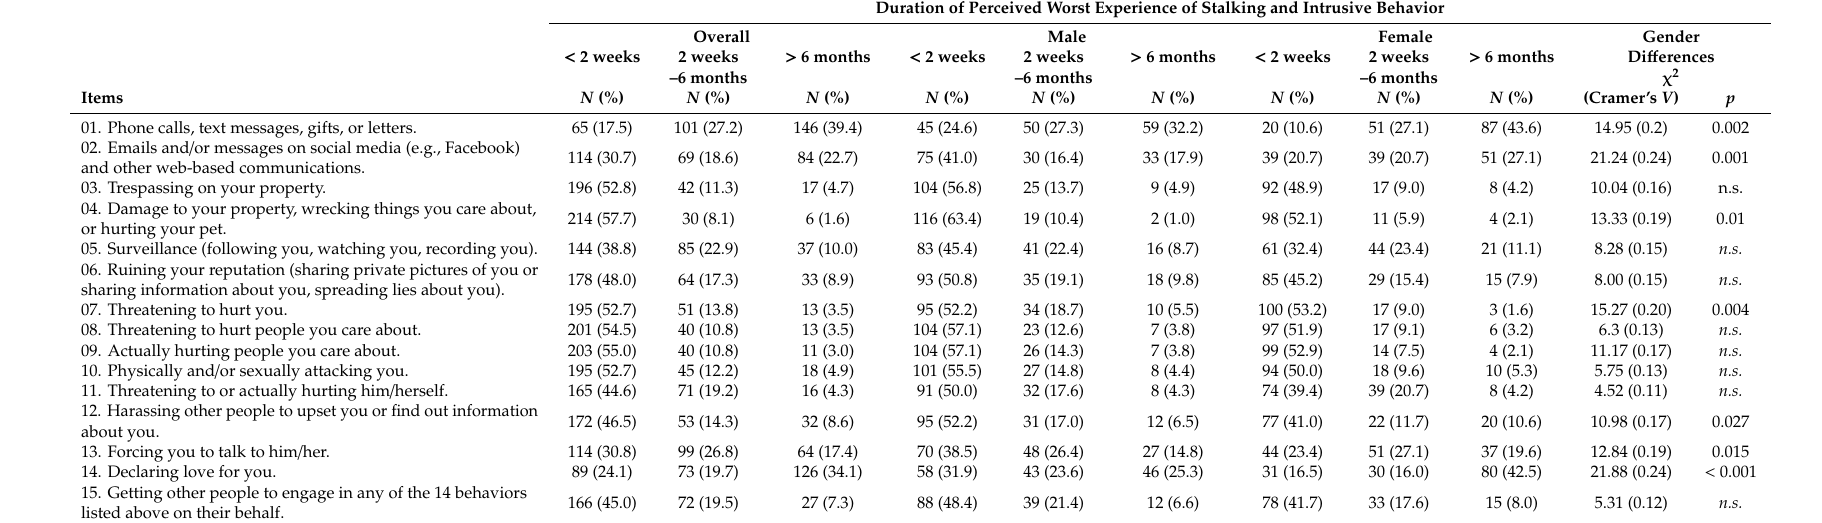
Table 4. Gender di ff erences on duration of perceived worst experience of stalking and intrusive behavior ( N = 371). Duration of Perceived Worst Experience of Stalking and Intrusive Behavior Overall Male Female Gender < 2